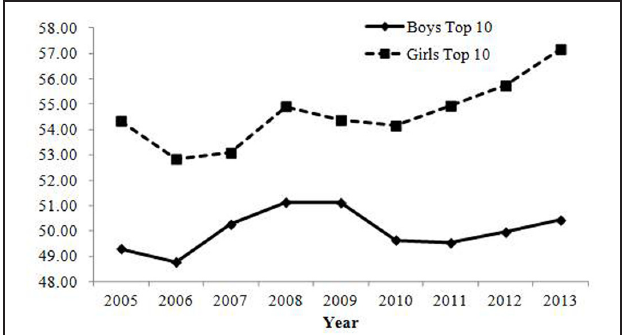
FIGURE 3 | Percentage of babies receiving names with one of the top 10 most common pronunciations in Study 1. The rate of babies with common pronunciation has decreased and changes were sufficiently large in